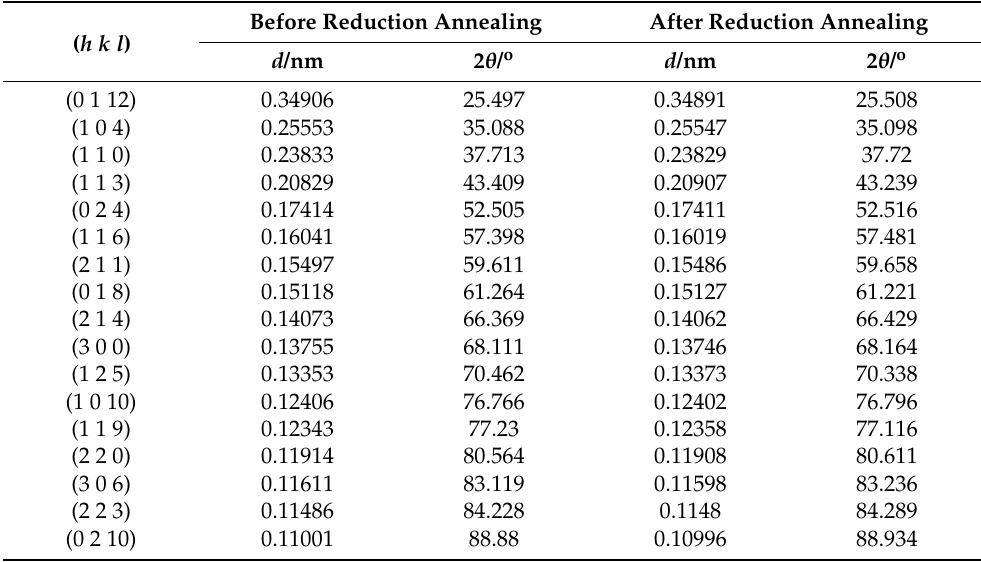
Figure 4. Rietveld refinement results of yellow sapphire obtained from XRD data: ( a ) before reduction annealing; ( b ) after reduction annealing. Table 3. Diffraction data of yellow sapphire from Rietveld refinement results.